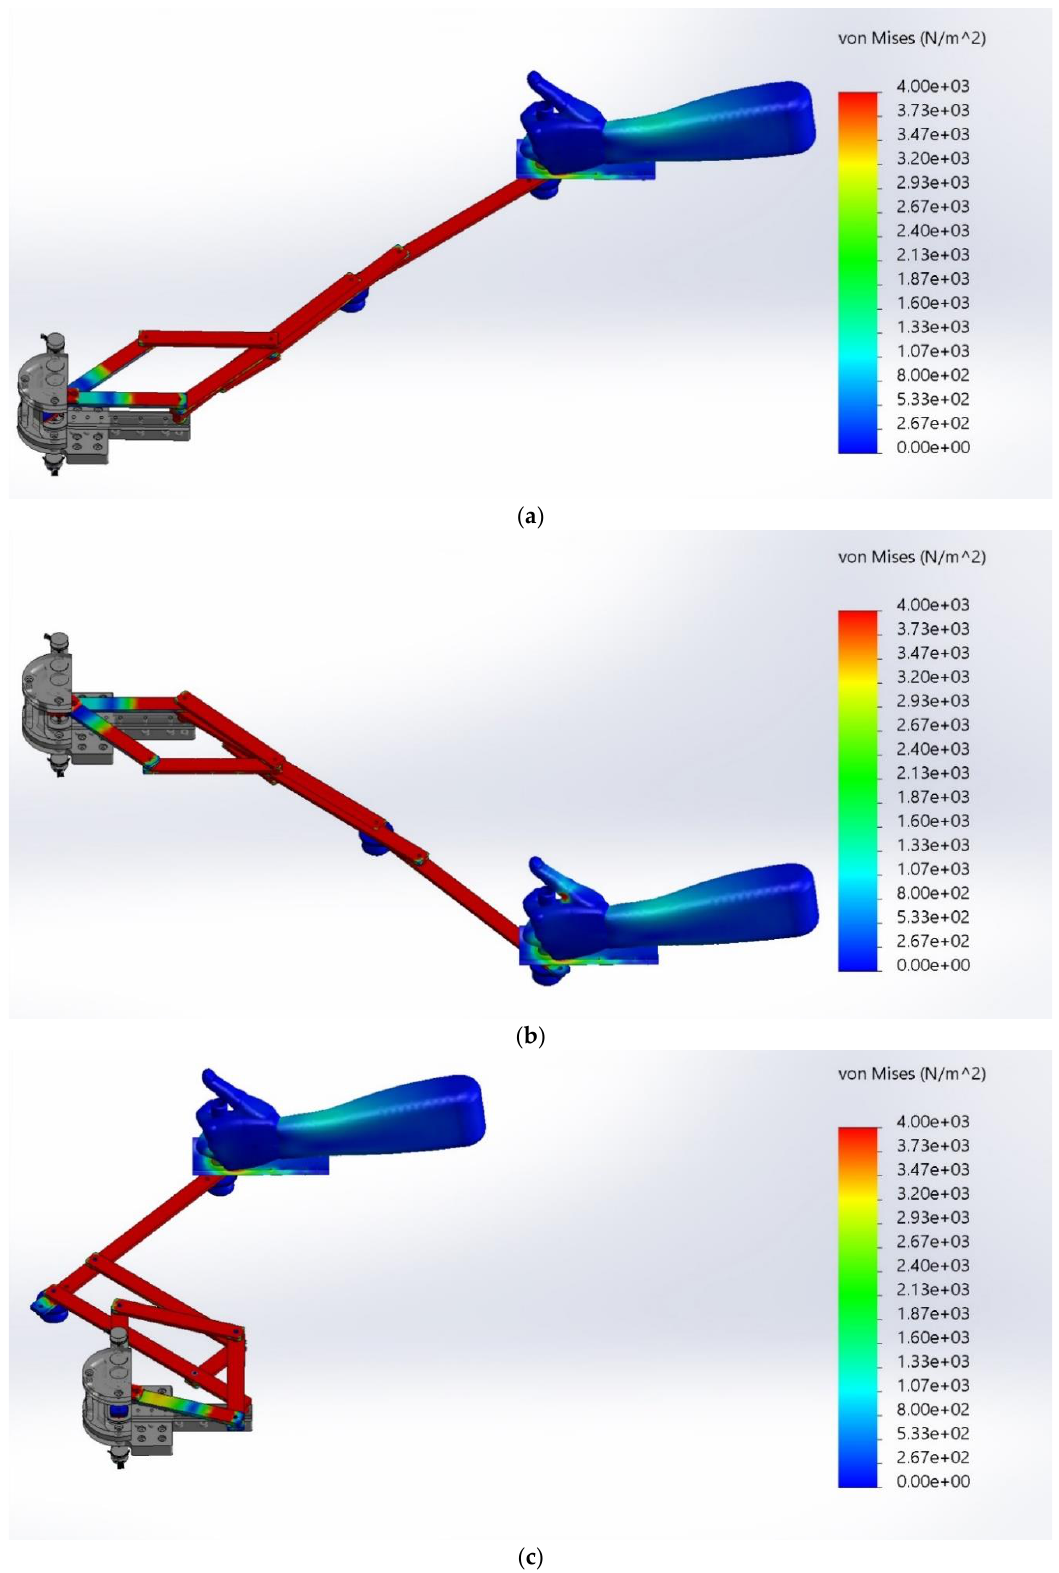
Figure 12. Stress results when Nurse reaches critical positions: ( a ) critical position a ( − 496,700); ( b ) critical position b (496,700); ( c ) critical position c ( − 496,148).